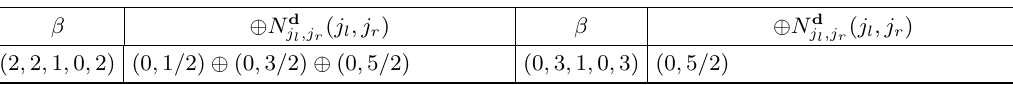
Table 21 . Refined BPS invariants of 6d n = 2 , G 2 model, with a su (2) mass turned